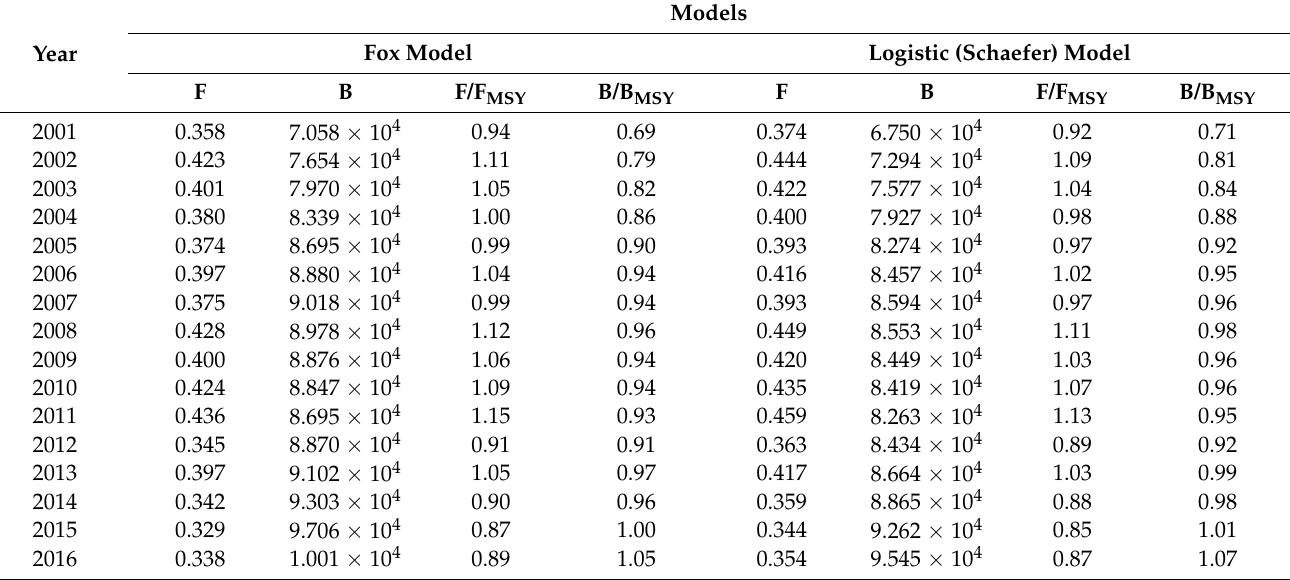
Table 2. Represented ASPIC-derived population parameters (F, B, F/F MSY, and B/B MSY ) of croaker in the BoB water from 2001 to 2018 using IP